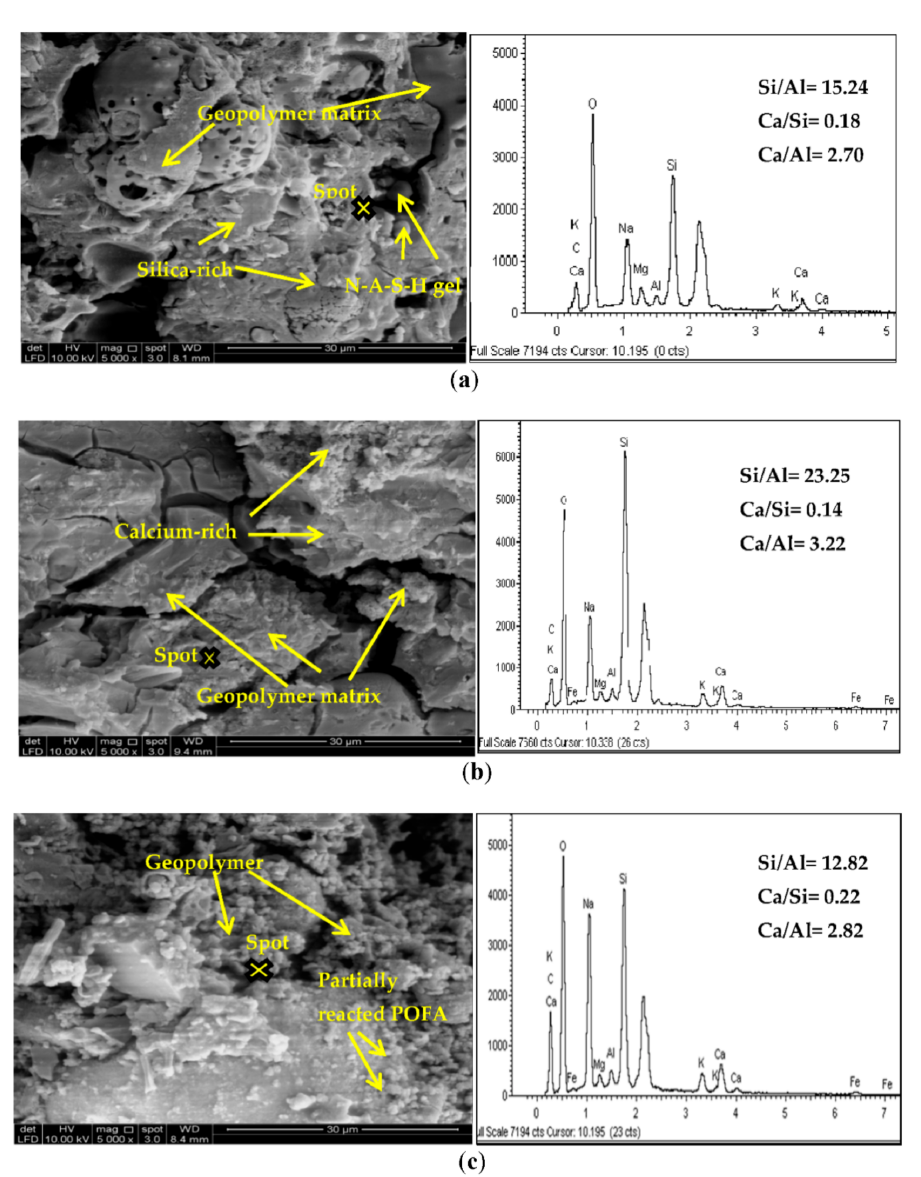
Figure 12. SEM images at 5000 × magnification and EDX of alkaline activated POFA